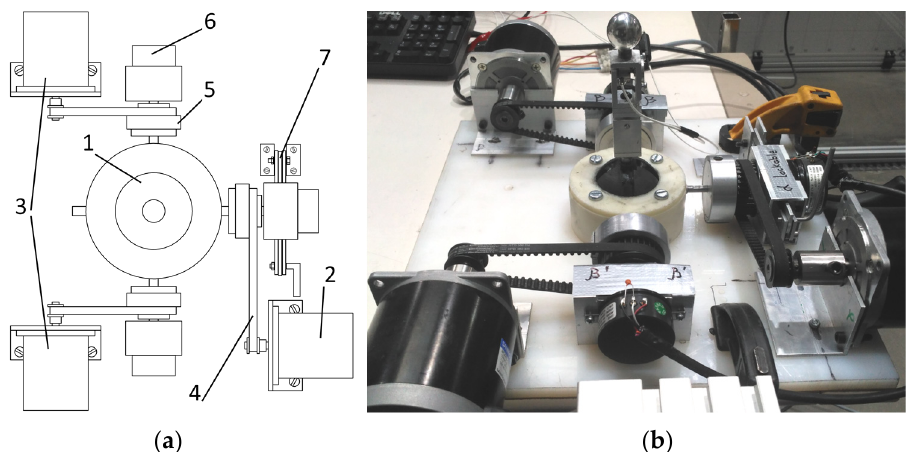
Figure 4. Haptic device with the active 2R spherical mechanism-based joint: ( a ) schematic representation: 1 the joint; 2 and 3 stepper motors; 4 belt drive; 5 step-to-torque transforming bushing; 6 rotary encoder; 7 clamping mechanism; ( b ) practical setup.